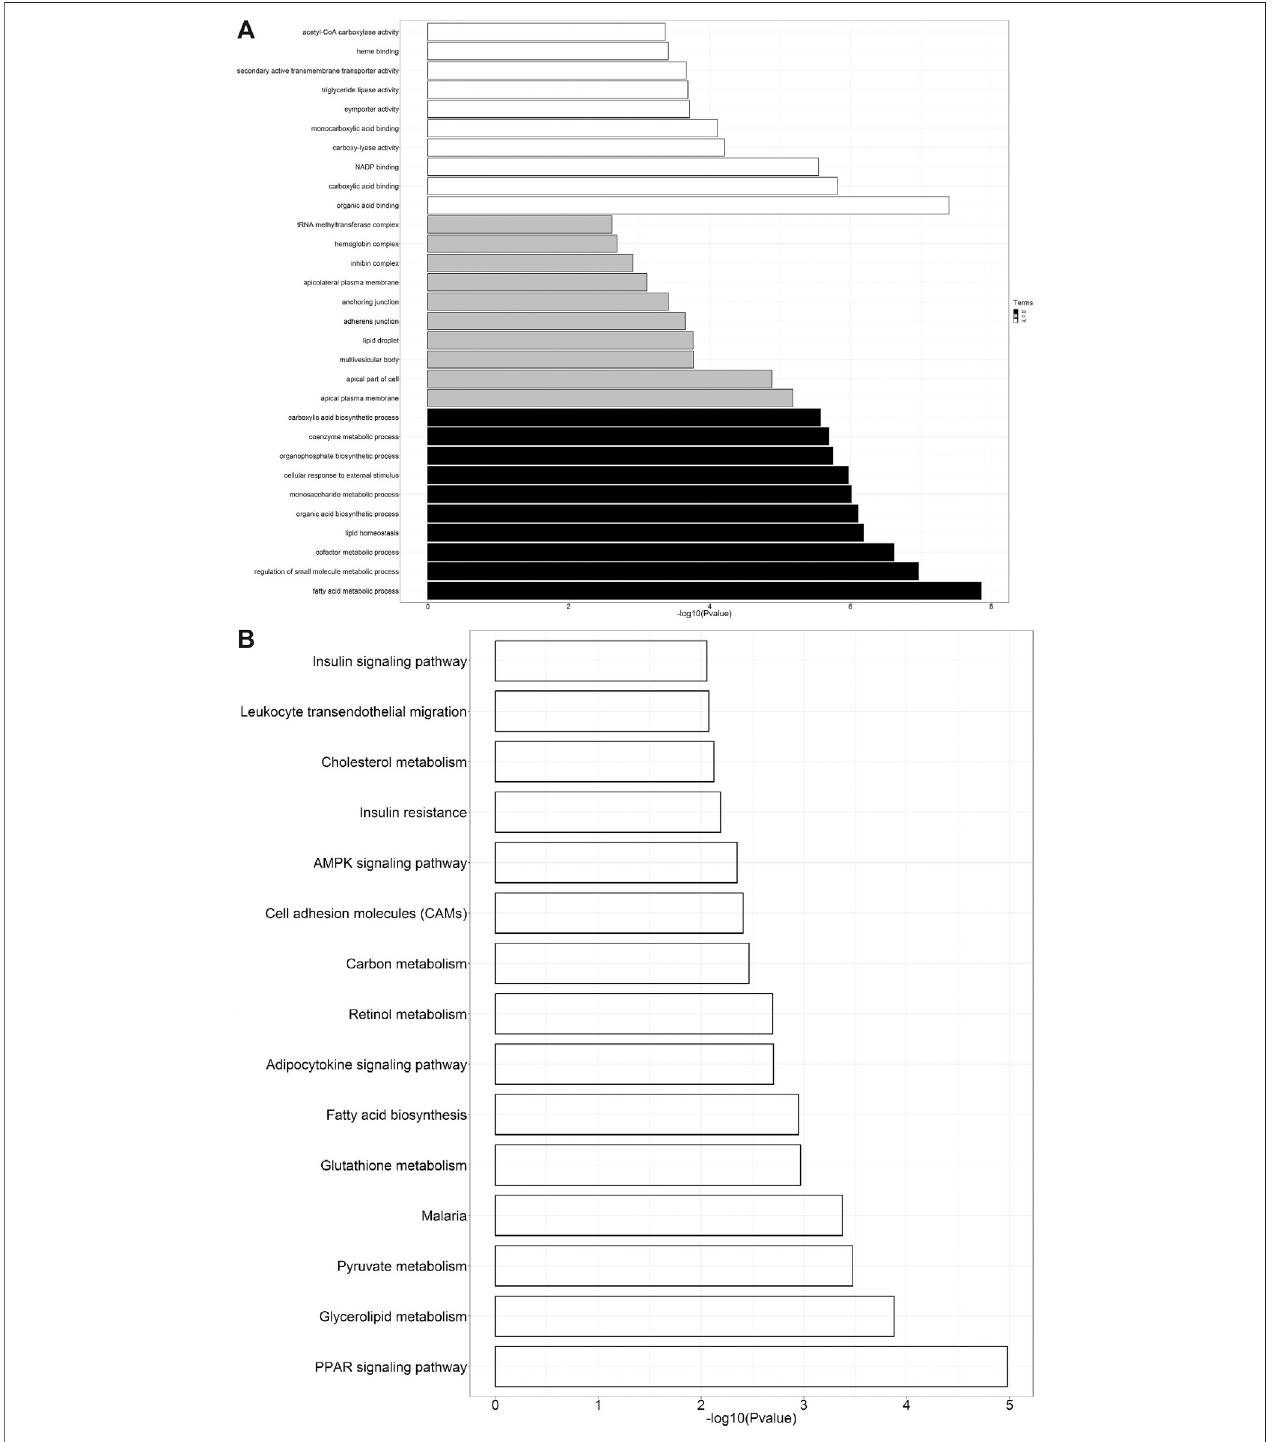
FIGURE4|(A) GOanalysisofDEGs.Theblackbarsrepresentbiologicalprocesses(bp),grayrepresentscellularcomponents(cc),andwhiterepresentsmolecular functions (mf). (B) KEGG pathway enrichment analysis of DEGs.